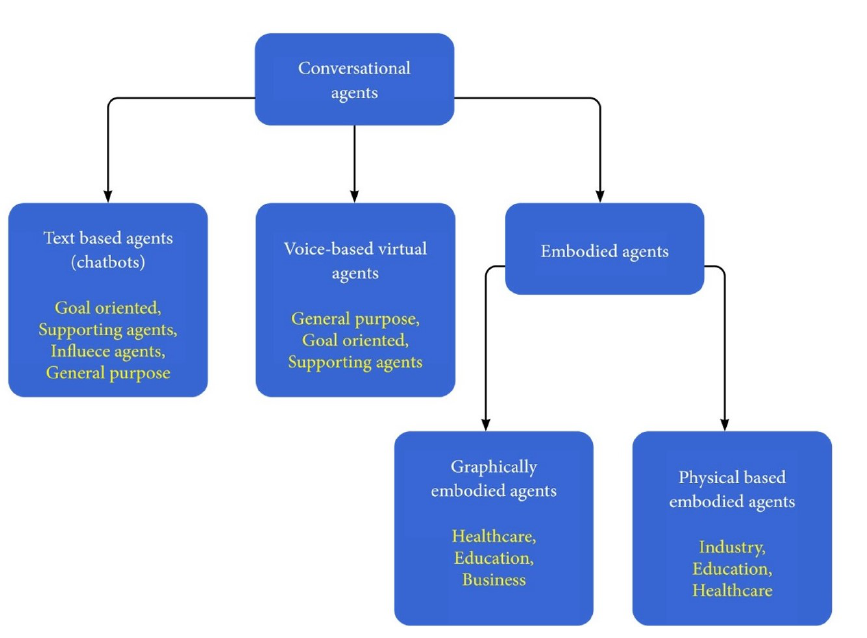
Figure 9. Conversational-agent